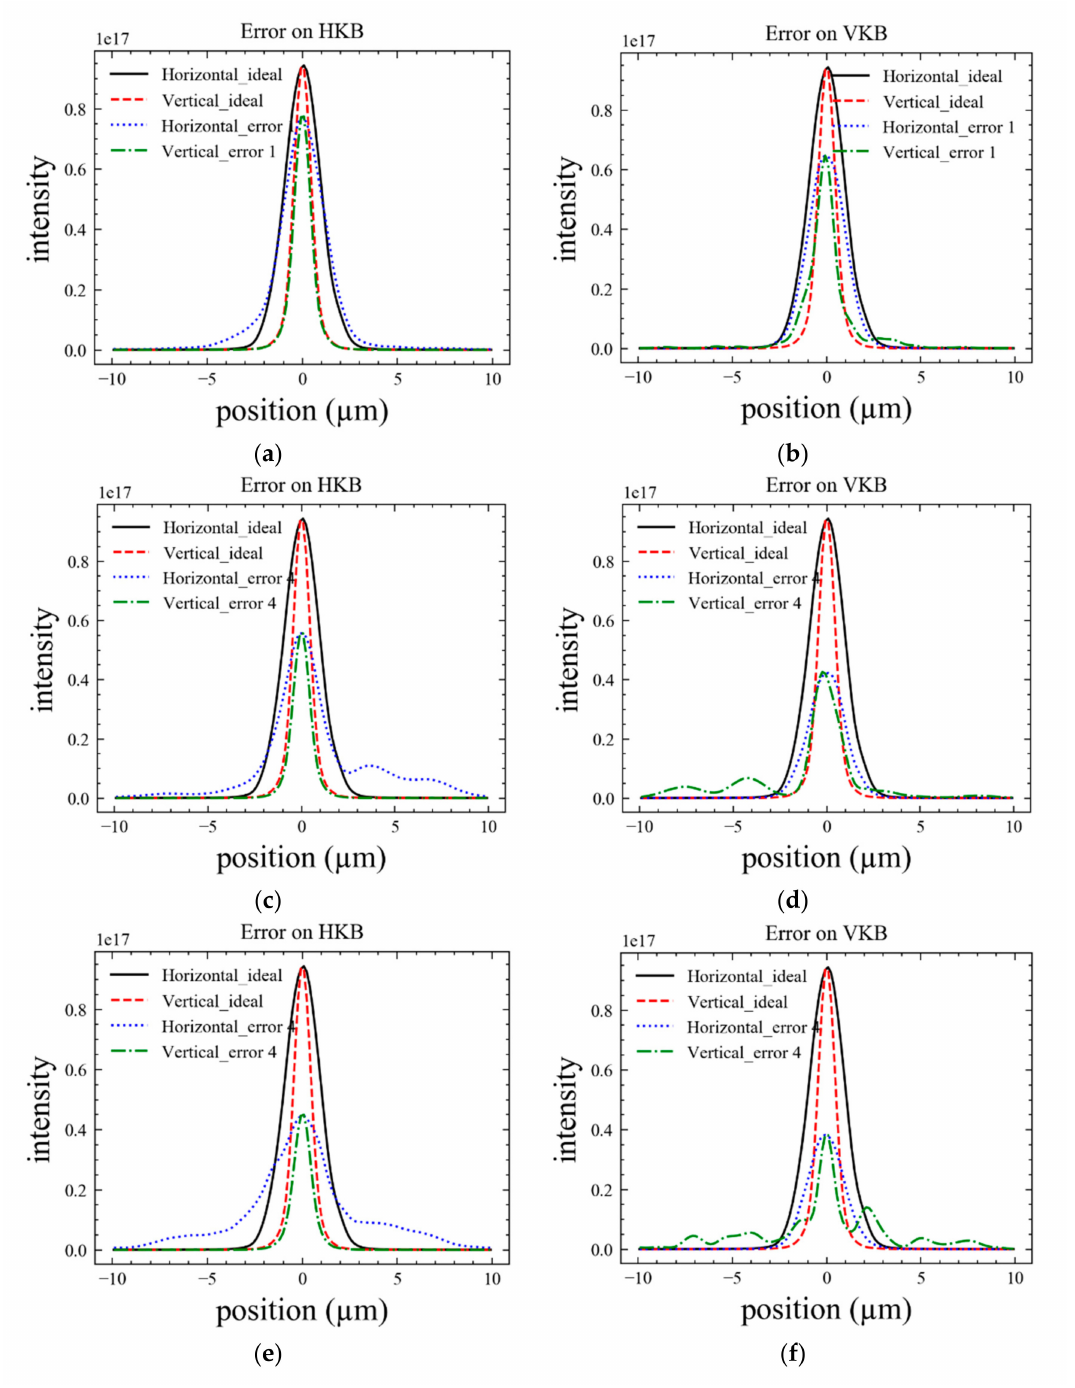
Figure 6. The plots of the intensity distribution with 15 µ rad acceptance angle for ( a , b ) CC1, ( c , d ) CC4, and ( e , f ) CC5. The error was added separately for ( a , c , e ); no error on VKB.